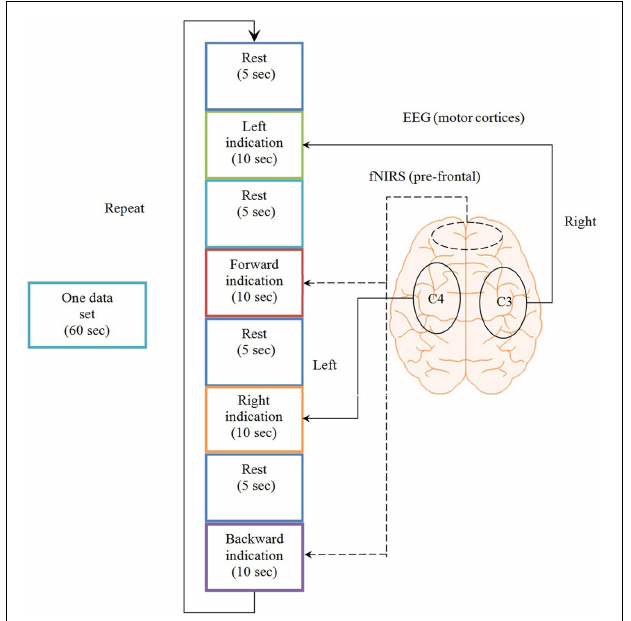
FIGURE 1 | Experimental paradigm. One complete data set over the span of a minute, consisting of four rest periods, two task periods detected by NIRS from the prefrontal brain region and two motor execution periods detected from C3 and C4 regions of brain using EEG.